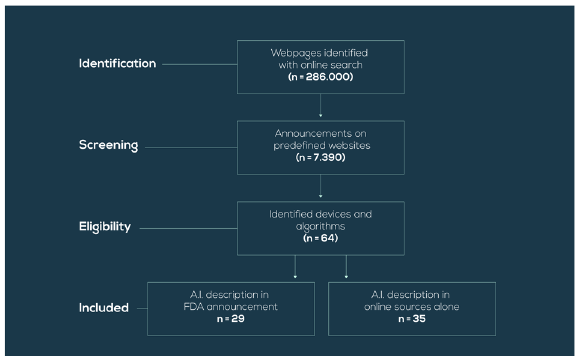
Fig. 2 Flowchart for the selection of AI/ML-based algorithms for this online database, including the number of identi fi ed webpages, the number of screened announcements, the number of eligible devices and algorithms, and the fi nal number of included AI/ML-based devices and